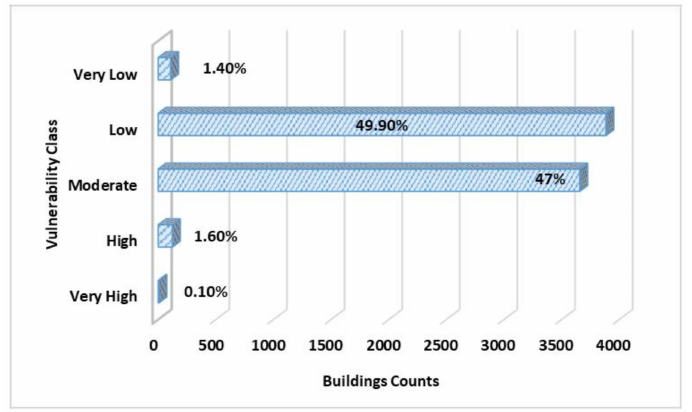
Figure 11. Frequency distribution of building flood vulnerability index